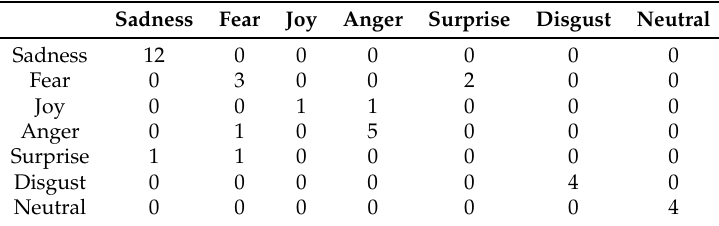
Table A23. A6 actor confusion matrix from the Emo-DB in the third phase.